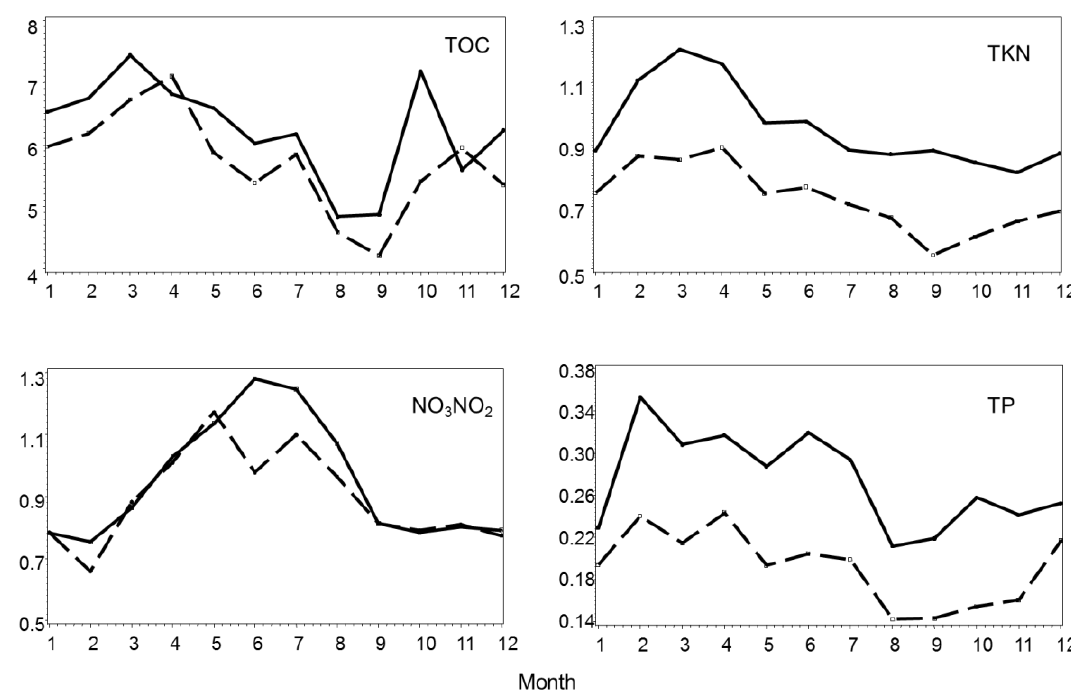
Figure 4. Long-term (1978–2004) average monthly concentrations of total organic carbon (TOC), total Kjeldahl nitrogen (TKN), nitrate/nitrite nitrogen (NO phosphorus (TP) in the inflow waters at Simmesport (solid lines) and outflow waters at Morgan City (dashed lines) in the Atchafalaya River.